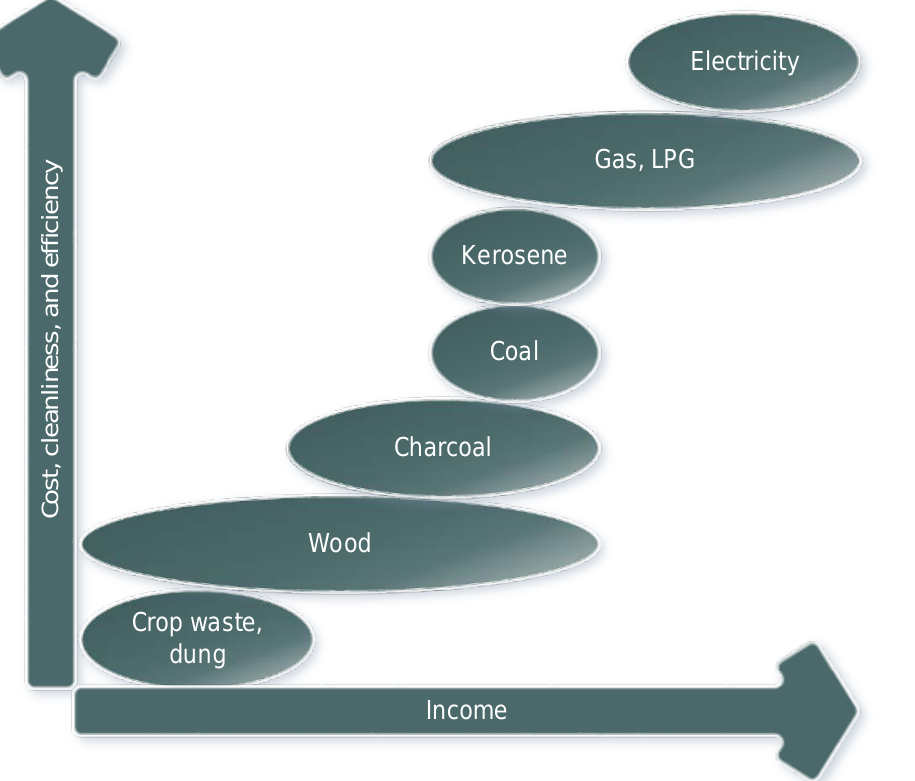
Figure 7. Energy ladder model, modified from the WHO [124].